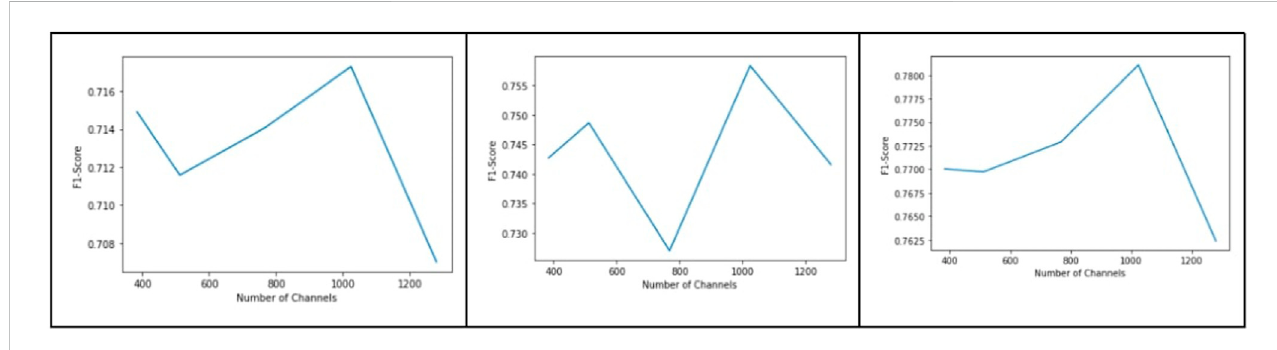
FIGURE 11 BV segmentation results on the IDRiD dataset using the model trained with images selected from DRIVE, HRF, and CHASE_DB.